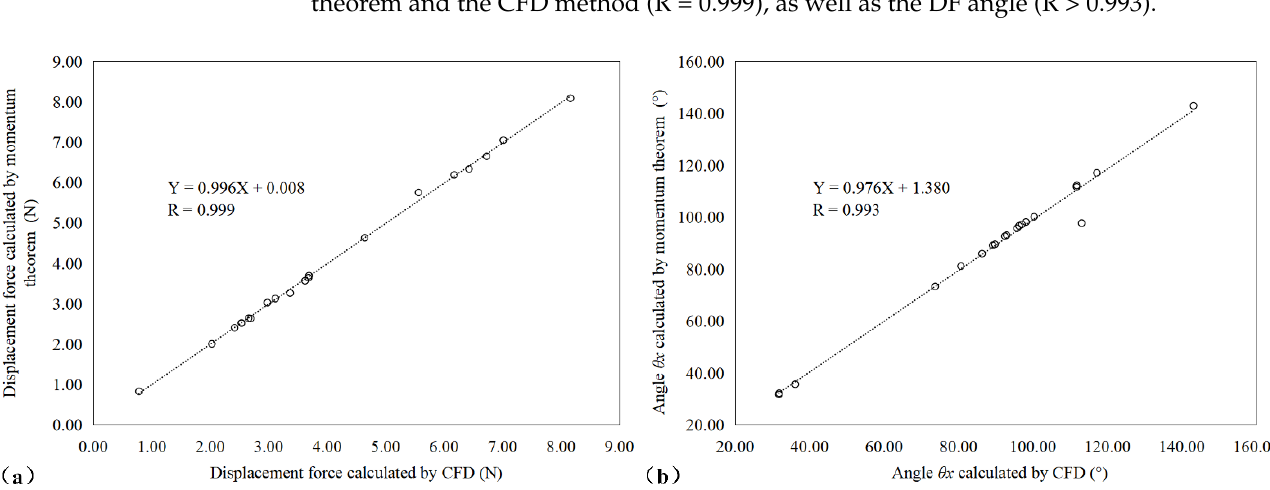
Figure 4. Linear scatter diagram showing the correlation between the magnitude of ( a ) displace- ment force ( b ) 𝜃𝜃 𝑥𝑥 , ( c ) 𝜃𝜃 𝑦𝑦 , and ( d ) 𝜃𝜃 𝑧𝑧 as calculated by the simplified momentum theorem and CFD method. The Bland–Altman plot (Figure 5) shows that there was only a small deviation be- tween the magnitude of the DF calculated by the momentum theorem and the CFD method (the upper and lower limits of DF consistency calculated by the two methods